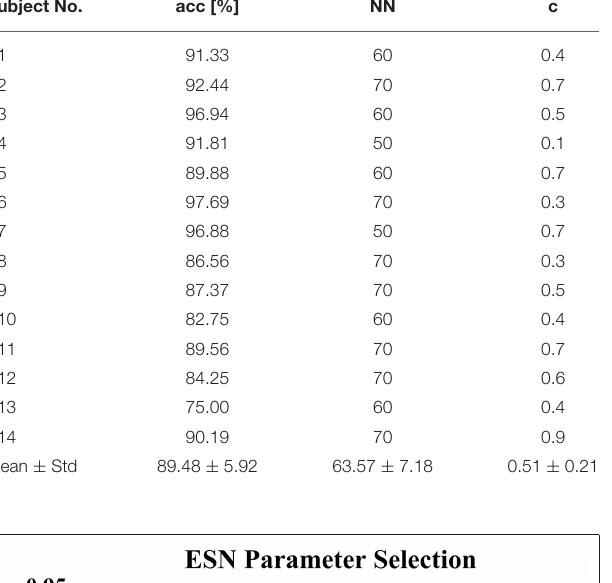
TABLE 2 | Subject-specific decoding accuracies and parameters selected ( NN and c ) under W-OHM by using the proposed model. Subject No.